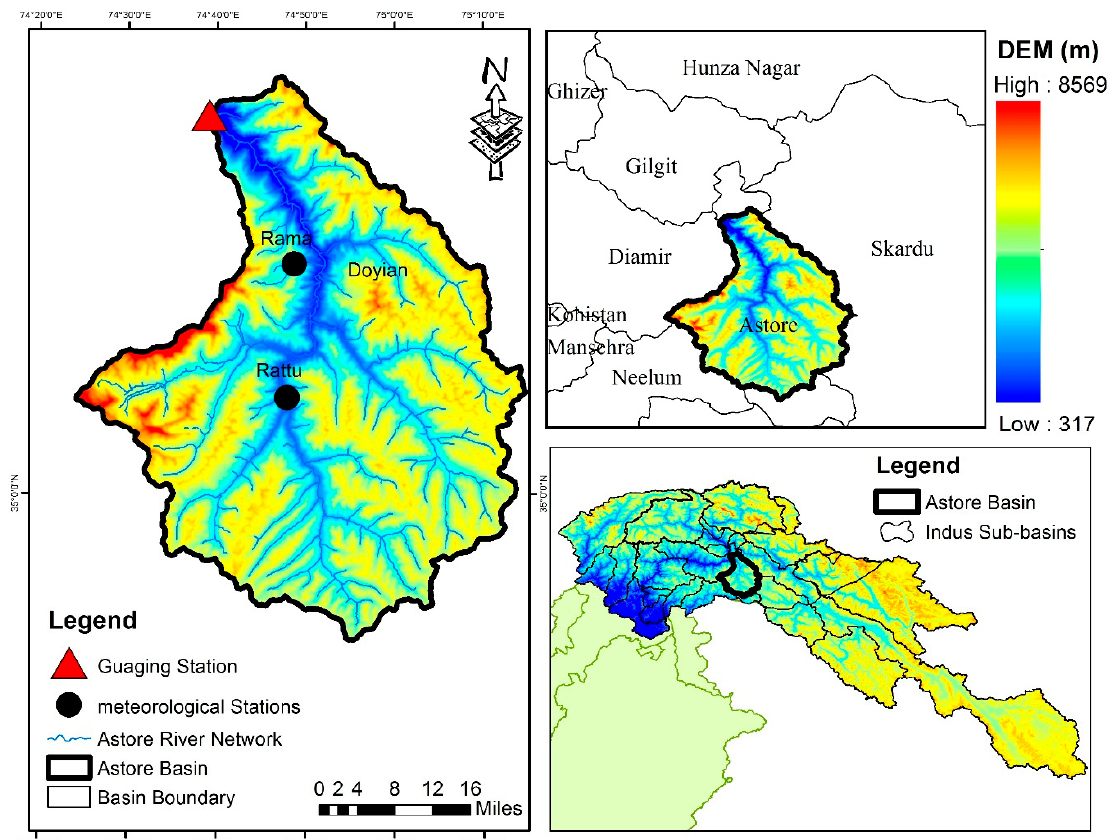
Figure 1. Map of study area Astore sub-basin of Upper Indus Basin (UIB), Pakistan along with hydro-meteorological stations.